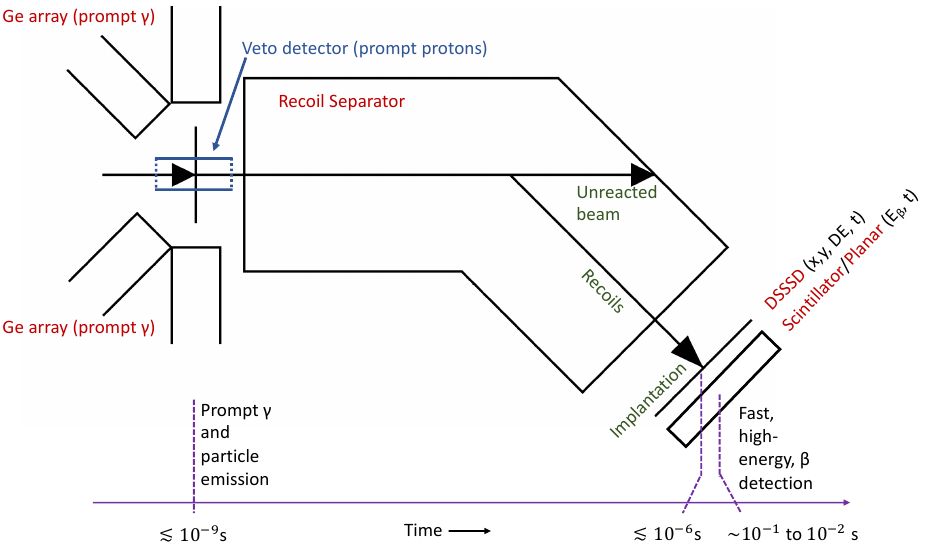
Figure 2. A schematic diagram summarising the recoil-beta-tagging technique, [29] used for iden- tifying prompt γ decays, emitted from proton-rich nuclei through tagging with the characteristic superallowed β -decay of the residue ground state. See text for